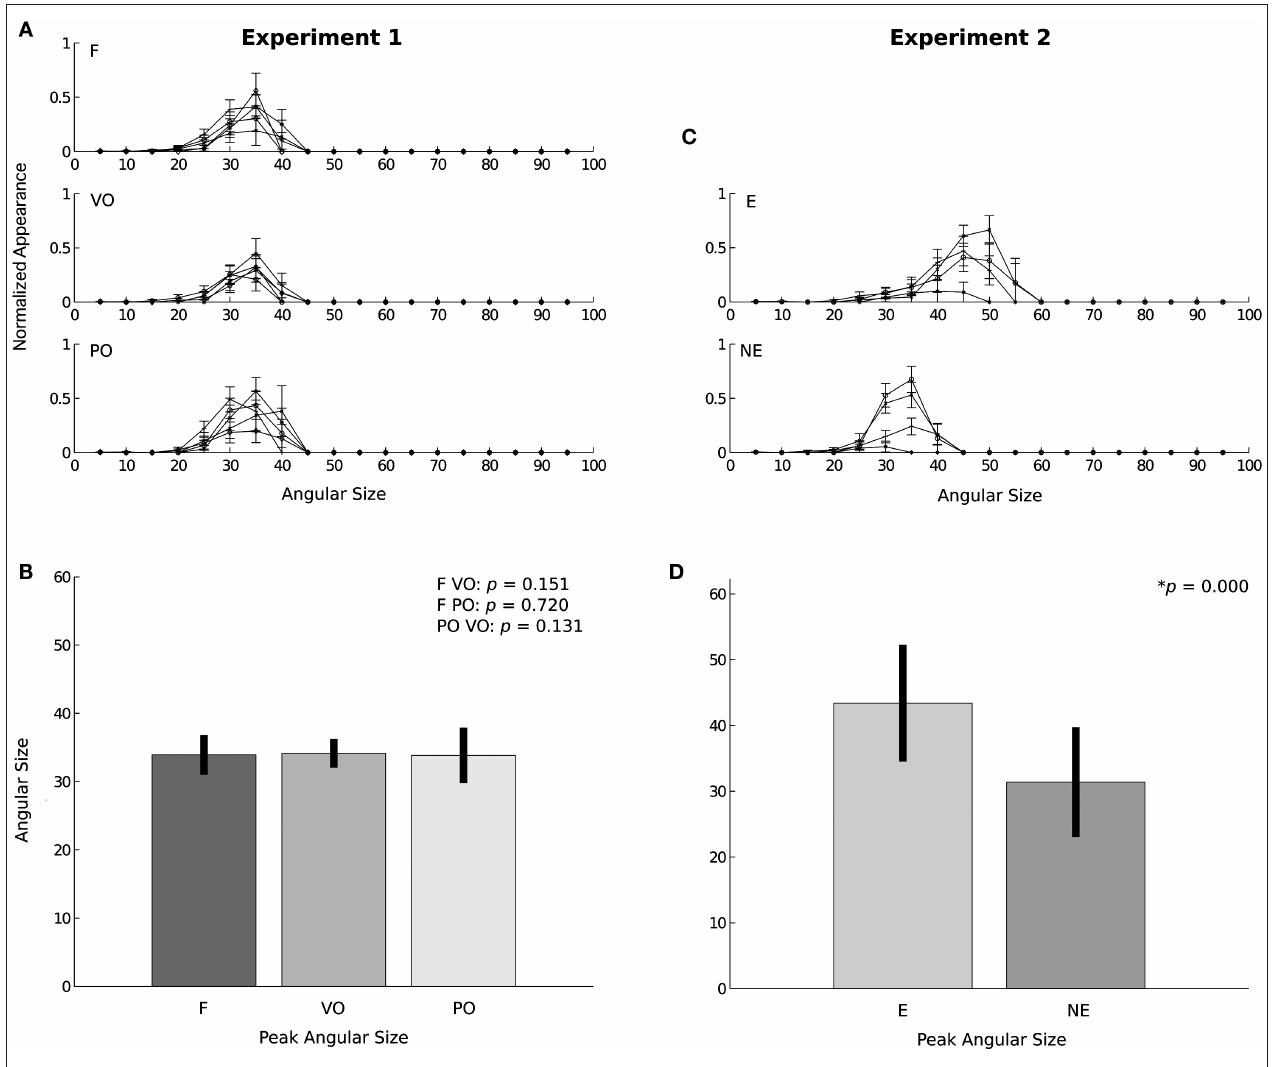
FigurE 3 | results. (A,C) Distributions of the maxima obtained from the bootstrapped samples and the SD for each subject grouped according to the conditions applied, for experiment 1 and experiment 2, respectively. (B,D) Statistical differences in the means of the distributions of the maxima and SD for experiment 1 and experiment